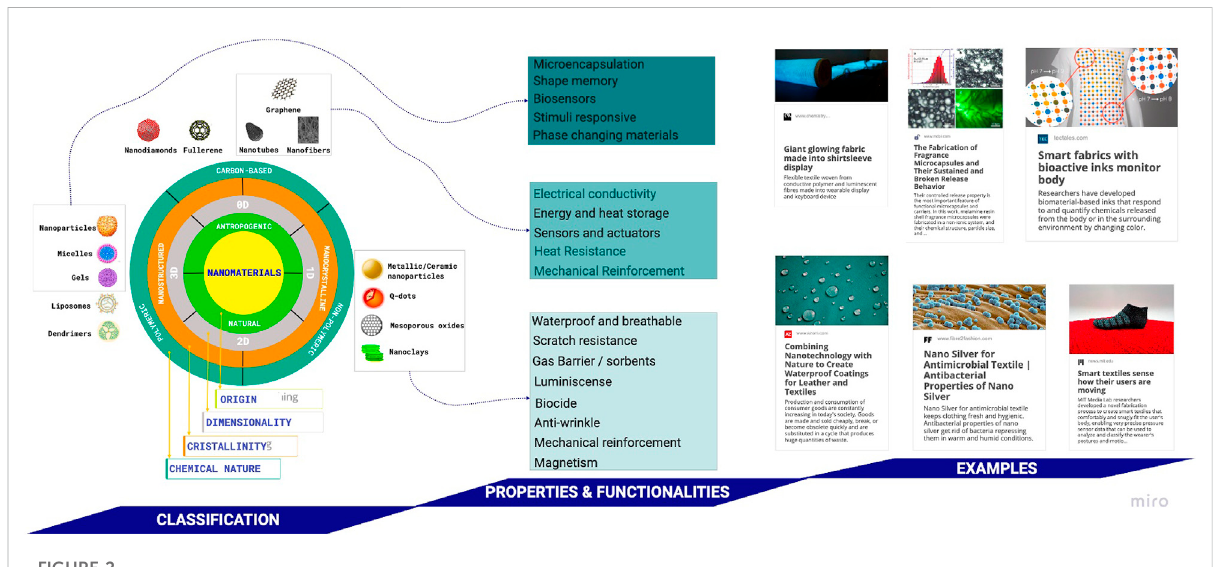
FIGURE 2 Scheme of the types of nanomaterials that can be used in the biotextile industry according to several properties of interest and their